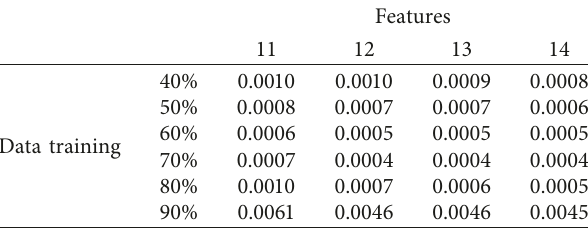
Table 2: PSO-SVR NMSE values of JKSE.